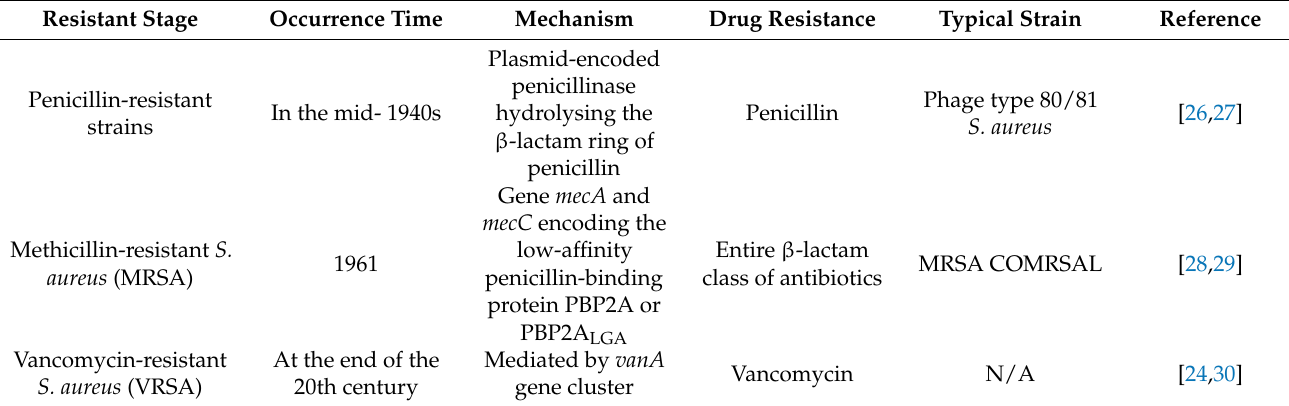
Table 1. Different drug-resistance stages of S. aureus